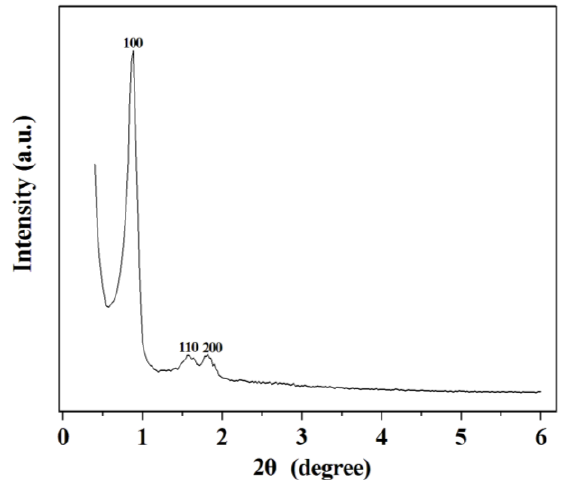
Figure 1. Powder XRD pattern of mesoporous silica SBA-15.